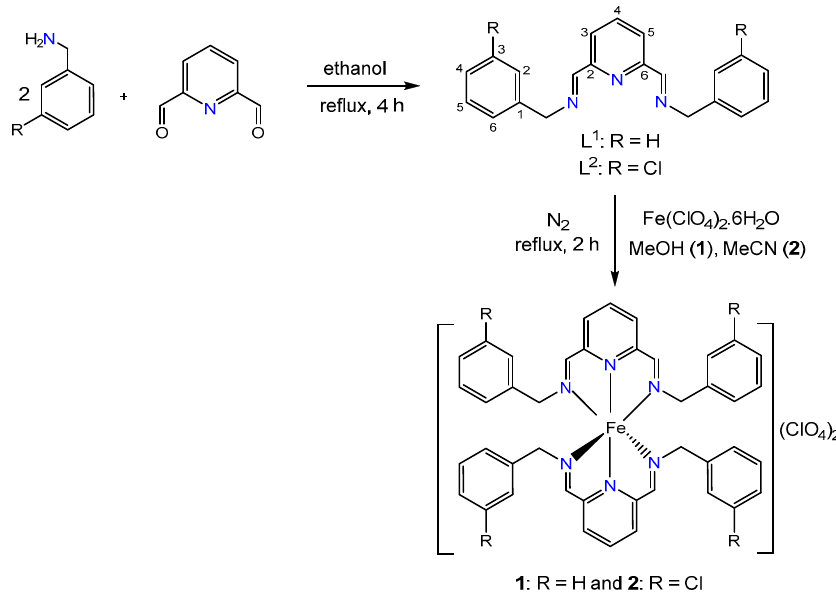
Scheme 1. Synthetic route for ligands L 1 , L 2 and complexes 1 and 2 .